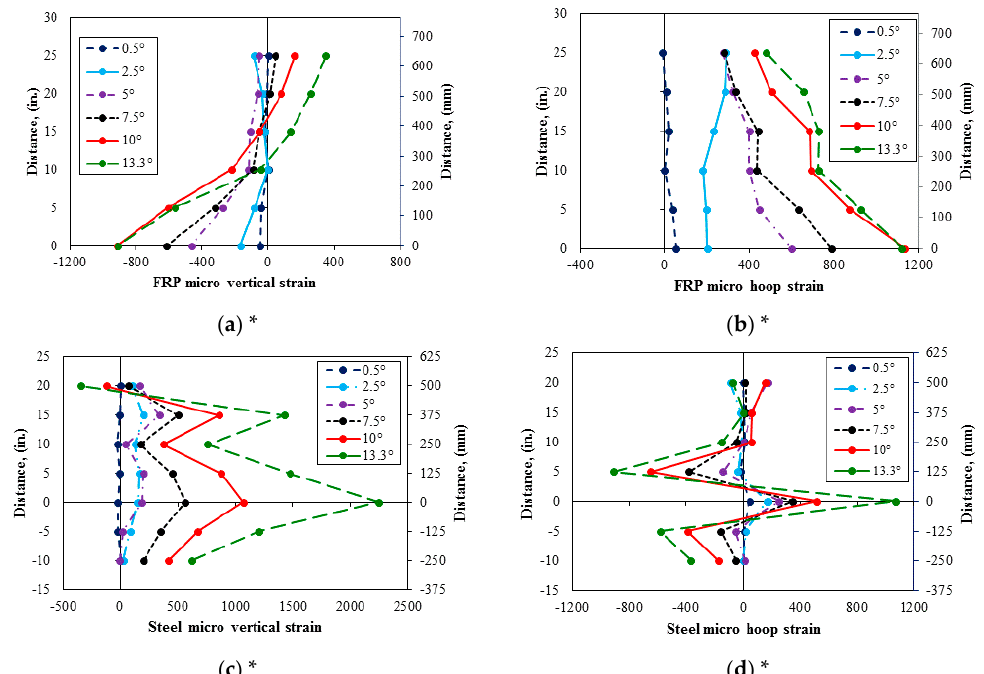
Figure 11. Strain profile along the height of the column: ( a ) GFRP vertical ( b ) GFRP horizontal, ( c ) steel vertical, and ( d ) steel horizontal. * Scale was different.